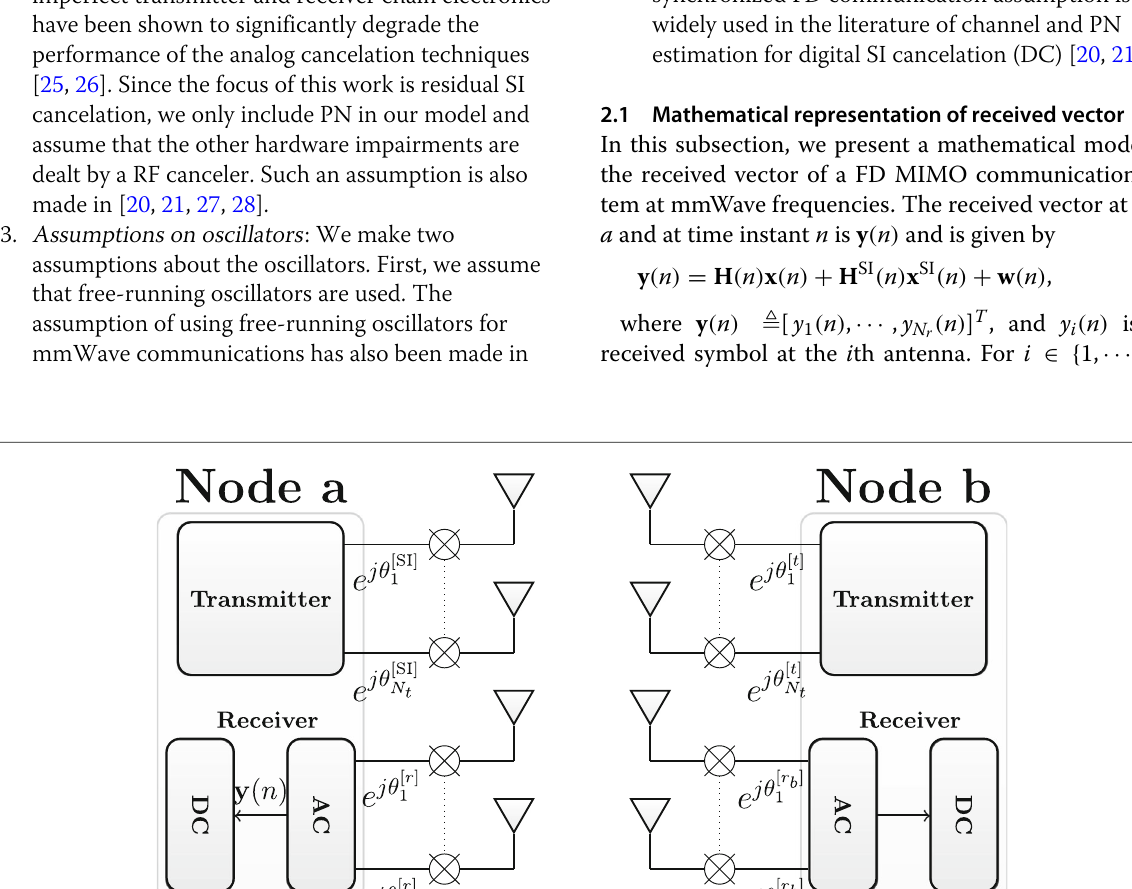
Fig. 1 System model block diagram of FD communication, where AC stands for analog SI cancelation, DC stands for digital SI cancelations, e j θ represents the PN at the l th